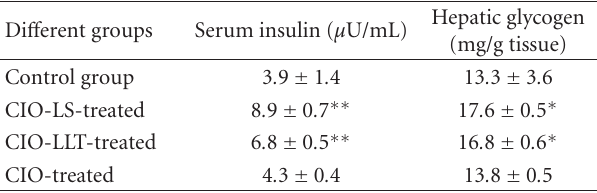
Table 5: E ff ect of CIO, CIO-LS and CIO-LLT on serum insulin and hepatic glycogen level in alloxan-induced diabetic